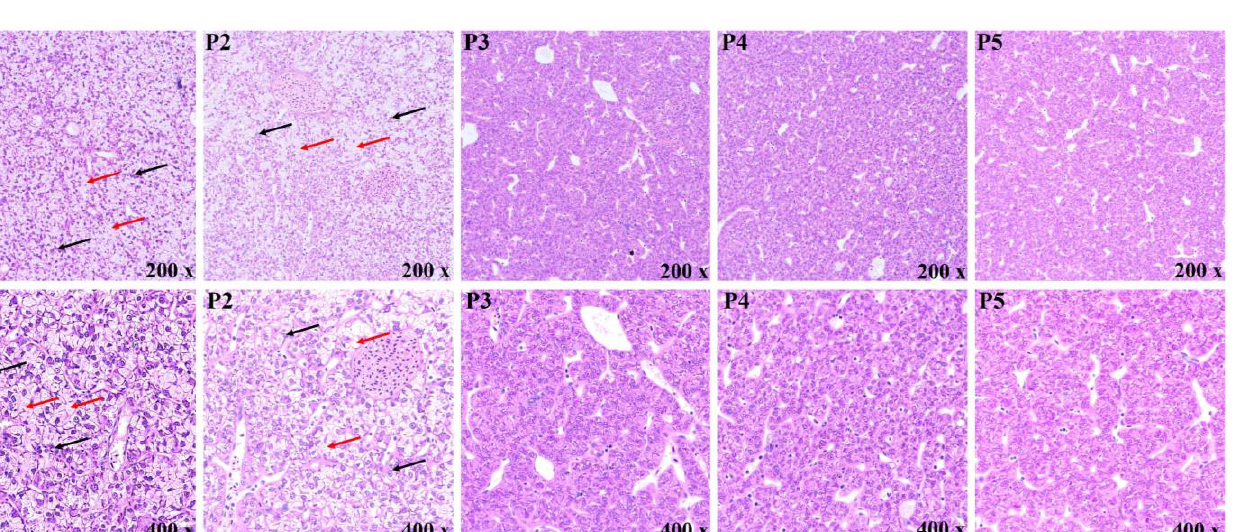
Figure 3. The mRNA levels of growth-related genes in the livers of Oncorhynchus mykiss fed experi- mental diets. Values are presented as mean ± SE, n = 4. Means with different superscripts are signif- icantly different ( p < 0.05). IGF-I: ANOVA, 0.000; linear, 0.000; quadratic, 0.000. IGFBP1: ANOVA, 0.000; linear, 0.000; quadratic, 0.000. The transcription levels of antioxidant-related genes in the liver are given in Figure 4. Catalase ( CAT ), glutathione peroxidase ( GSH-PX ) and SOD expressions increased line- arly and quadratically with the increase in protein levels. Fish fed the P3, P4 and P5 diets